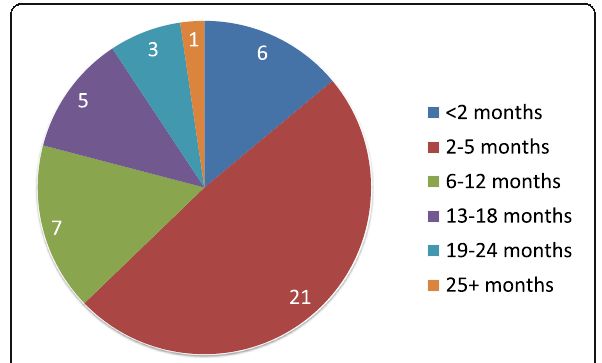
Fig. 1 Number of eyes versus the length of iritis. Legend: Fig. 1 shows the distribution of patients with prolonged inflammation based on the duration of iritis in